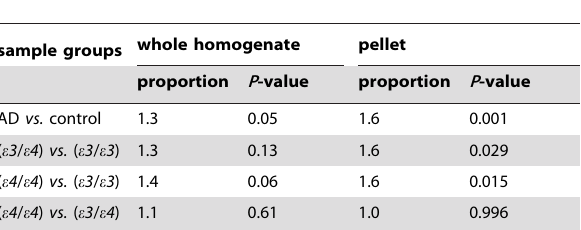
Table 2. Pair-wise comparison of the ratios of C-terminal domain vs. N-terminal domain quantification between sample